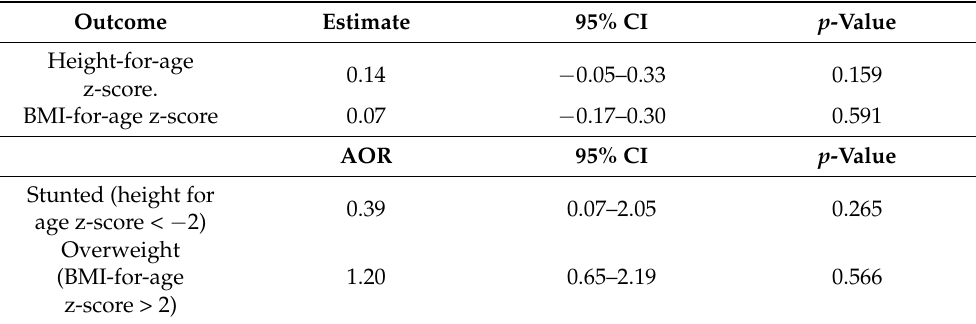
Table 2. Anthropometry: adjusted linear mixed models and generalized linear mixed models. Parameter estimates and adjusted odds ratios (AOR) shown for children that attended the Guatemala City Municipal